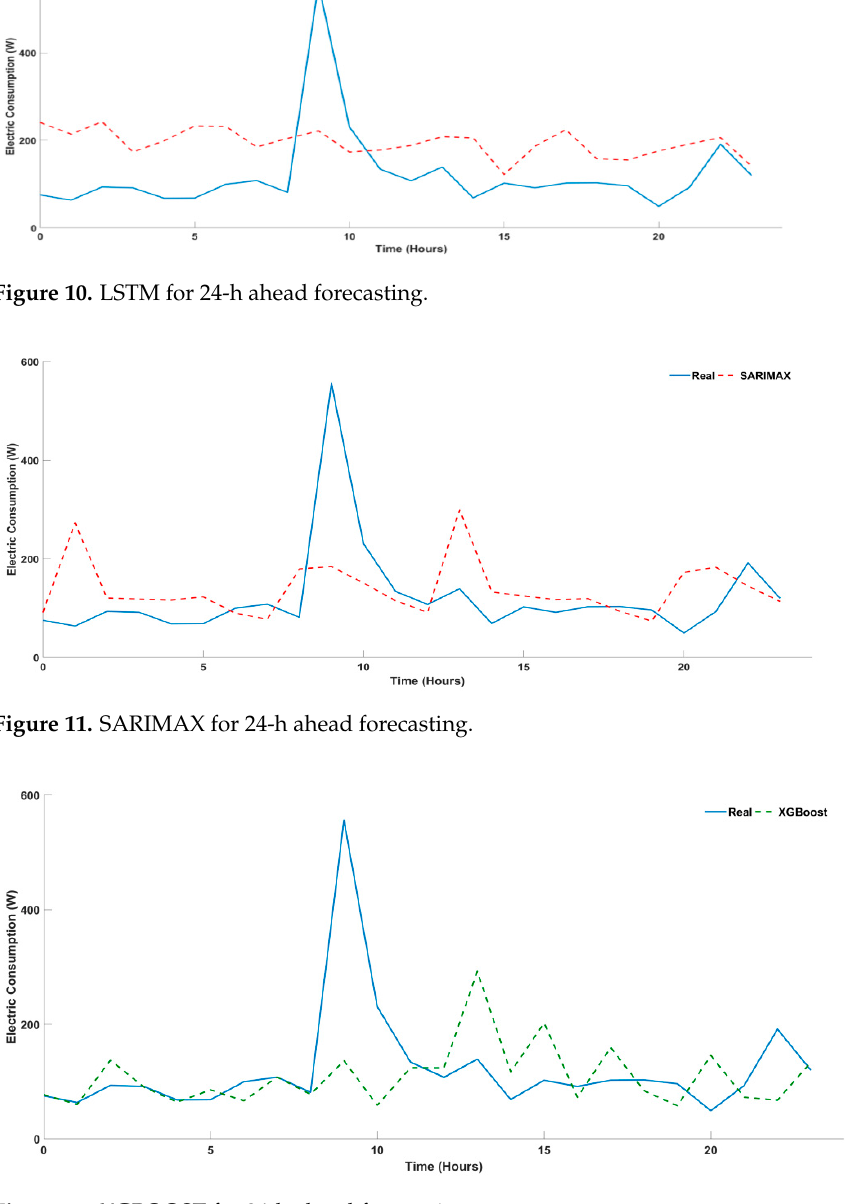
Table 7. Results Computational complexity for multistep ahead forecasting.